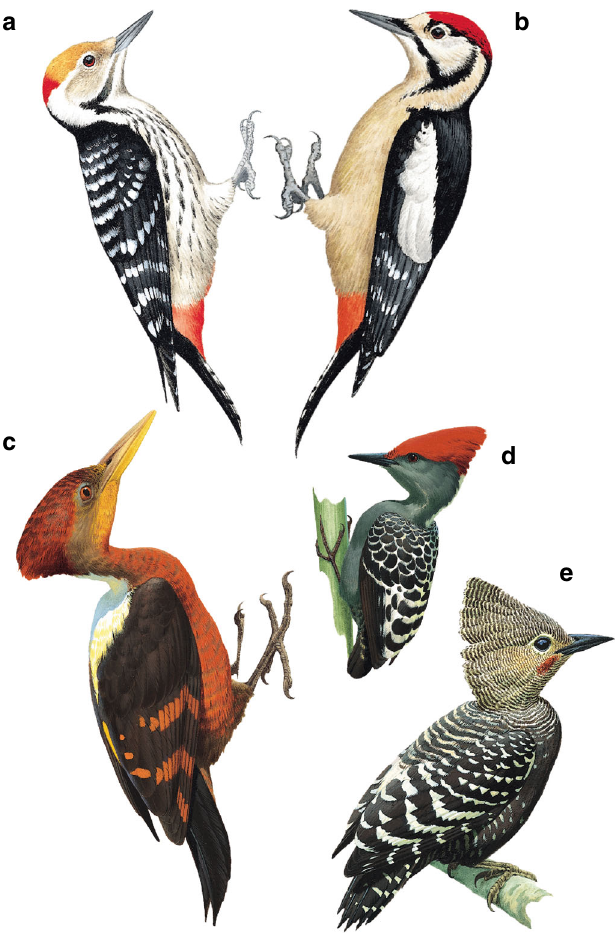
Fig. 1 Two groups of sympatric woodpecker species whose plumage has been shaped by co-occurring heterospeci fi cs. a Dendrocoptes auriceps and b Dendrocopos himalayensis replace one another elevationally in the Himalayas, and have diverged more than expected based on their shared evolutionary history, habitat, and climate. c Reinwardtipicus validus and d Hemicircus concretus are sympatric on the island of Java, and likewise have diverged notably in plumage. However, ( d ) and Meiglyptes tristis ( e ) have converged on one another in sympatry in Java; our ability to analytically disentangle these competing patterns is currently limited. Illustrations © HBW Alive/Lynx